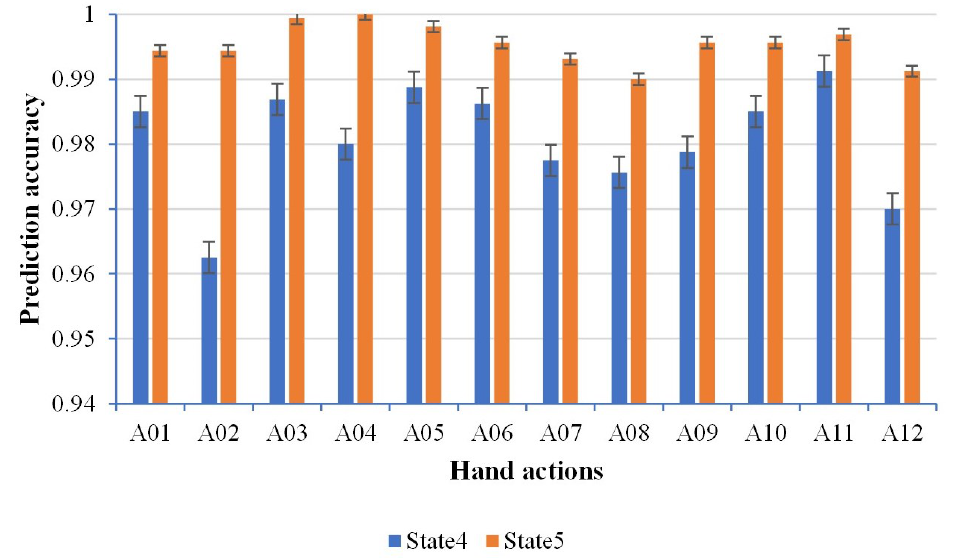
Figure 4. Prediction accuracy for two different settings of key state transition.